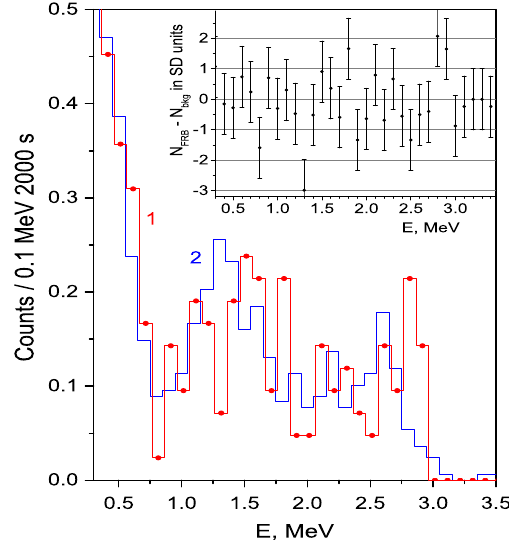
Fig. 1 Borexino events with an energy above 0 . 25 MeV occurring within ± 5000 s of FRB 200428 detection time Fig. 2 Borexino energy spectrum of singles in correlation with FRBs in the ± 1000 s time window (line 1 with dots). Line 2 shows the nor- malized background spectrum measured in [ − 5000 ... − 1000] s and [1000 ... 5000]sintervals.Theinsetshowsthedifferencebetweenthese spectra in terms of standard deviations